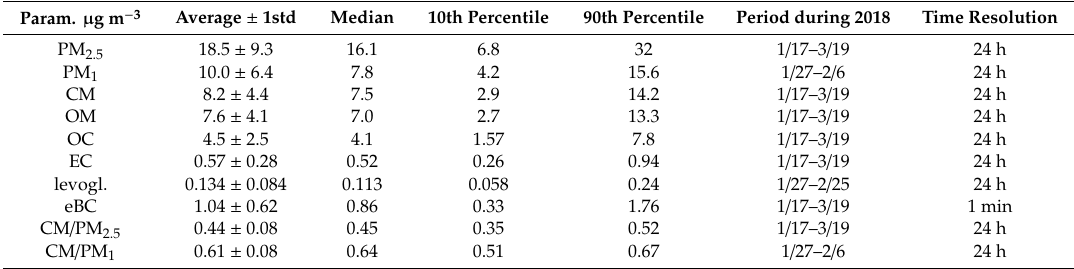
Table 1. Measured and calculated parameters based on 24-h measurements for all parameters except the 1 min measurements by the AE33 instrument. PM 1 and levoglucosan were measured for a shorter period than other parameters (and one 24-h PM 1 sample is missing in the period given in the table). CM and OM were calculated according to Equations (1) and (2). CM (carbonaceous matter), OM (organic matter), OC (organic carbon), EC (elemental carbon), and levoglucosan were measured for the PM 2.5 fraction, while eBC was measured for the PM 1